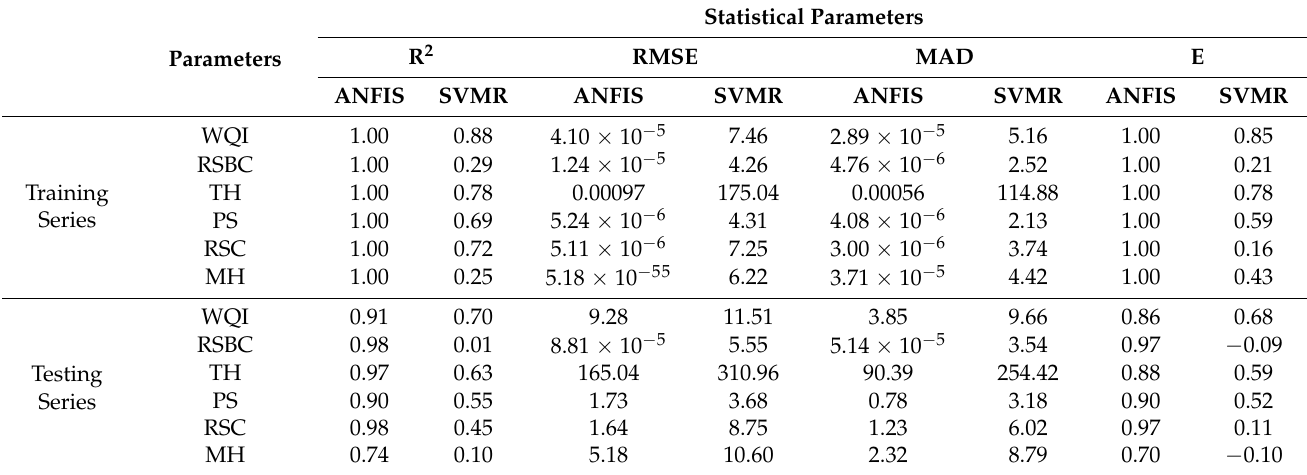
Table 5. Comparison of statistical parameters between adaptive neuro-fuzzy inference system (ANFIS) and support vector machine regression (SVMR) models of measured and simulated values of different irrigation water quality indices (IWQIs) including water quality index (WQI), residual sodium bicarbonate (RSBC), total hardness (TH), potential salinity (PS), residual sodium carbonate (RSC), and magnesium hazard